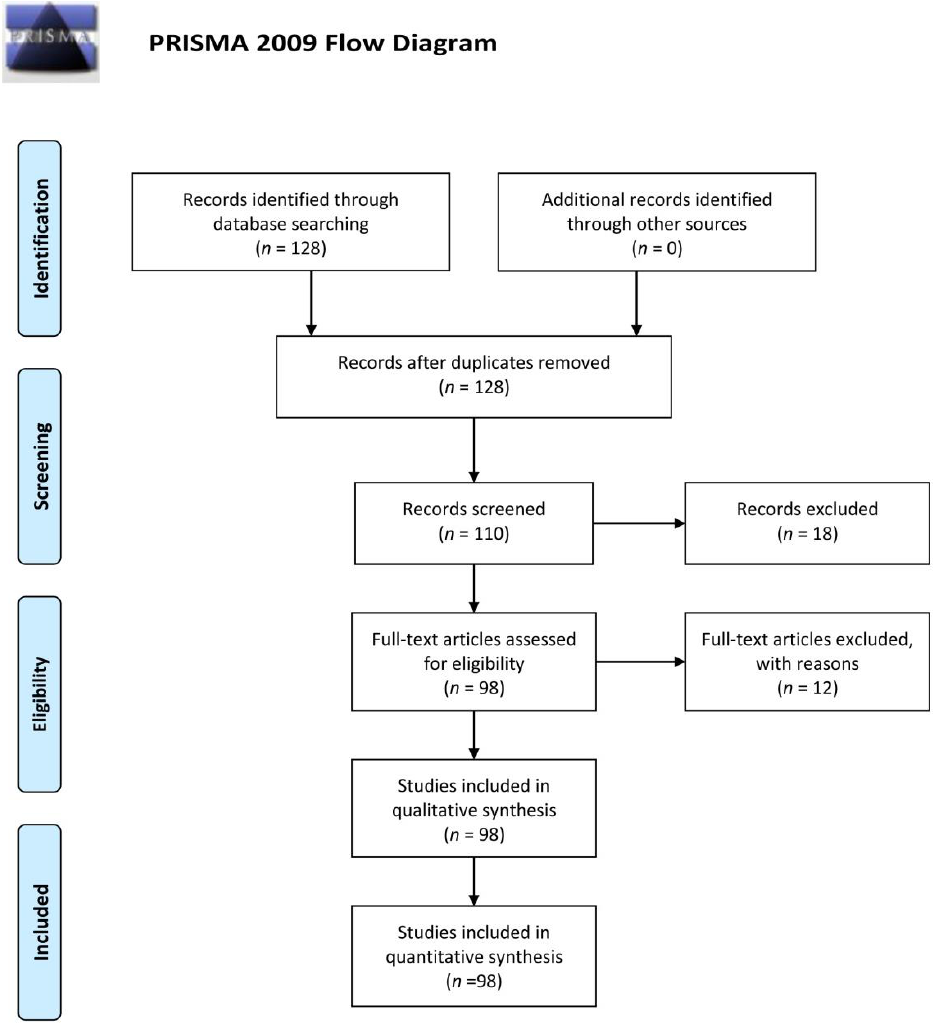
Figure 1. Flow diagram with the different phases of a systematic review (adapted from PRISMA, [21]).